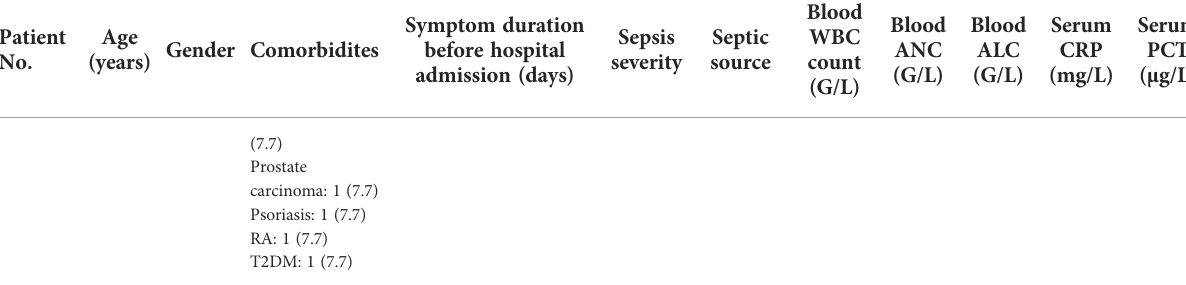
ICU LOS ICU Survival LOS (days) admission (days) Empirical Targeted